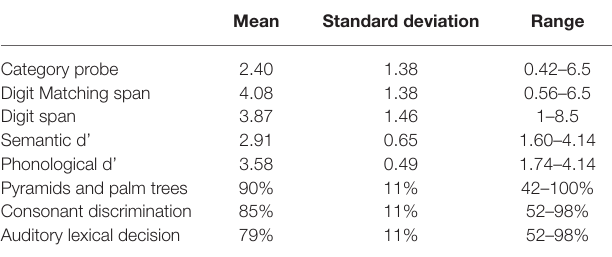
TABLE 4 | Descriptive statistics for participants’ behavioral task performance ( N = 53).